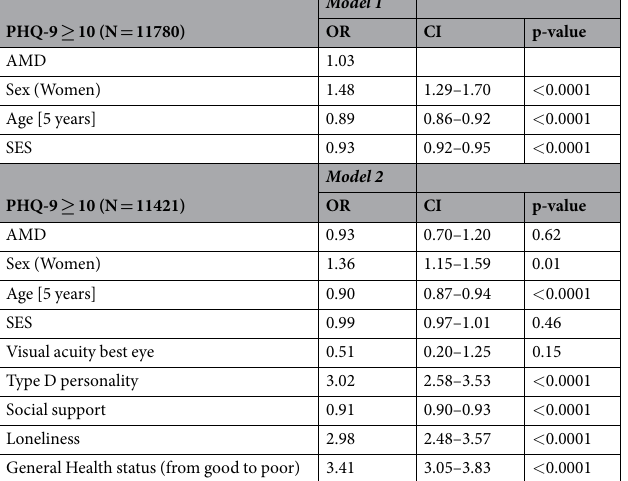
Table 4. Associations (multivariate logistic regression analysis) of AMD with depression in the Gutenberg Health Study (GHS) and significantly associated parameters. Abbreviations: CI (95% confidence Interval), OR (Odds ratio), PHQ-9 (Patient Health Questionnaire), SES (socioeconomic status). PHQ-9 ≥ 10 defined as caseness for depression. Model 1: Logistic regression analysis adjusted for age, sex, socio-economic status. Model 2 * : Additionally, adjusted for systemic comorbidities, self-reported ocular diseases, visual acuity of the best eye, mental health (Type D personality, loneliness, social support) and general health status. * not significantly associated parameters (systemic comorbidities, ocular diseases) are not presented in this table. Model 2 with full list of covariates can be found in the Supplementary Table